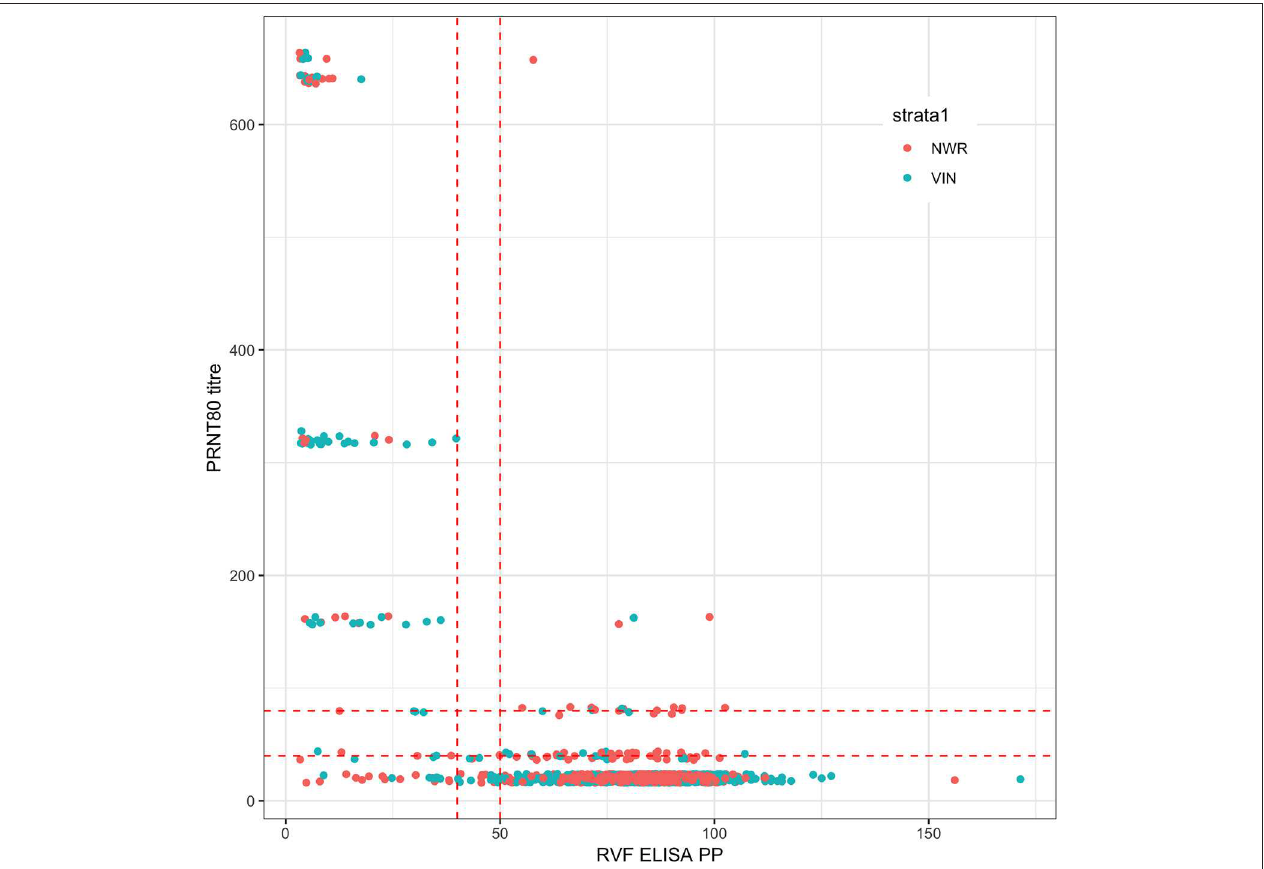
FIGURE 1 | Bivariate plot of the raw continuous values from the PRNT 80 and ID.Vet RVF tests. The points are colored by study site and jittered on the y axis. Horizontal and vertical lines in dashed red were added to mark the various cut-off values used. Note that for the PRNT 80 a positive result is greater than the cut-off while for the ID.Vet ELISA is lower than the